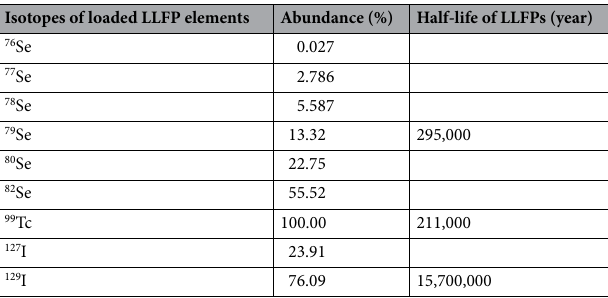
Table 9. Isotope abundance and half-life of loaded LLFP